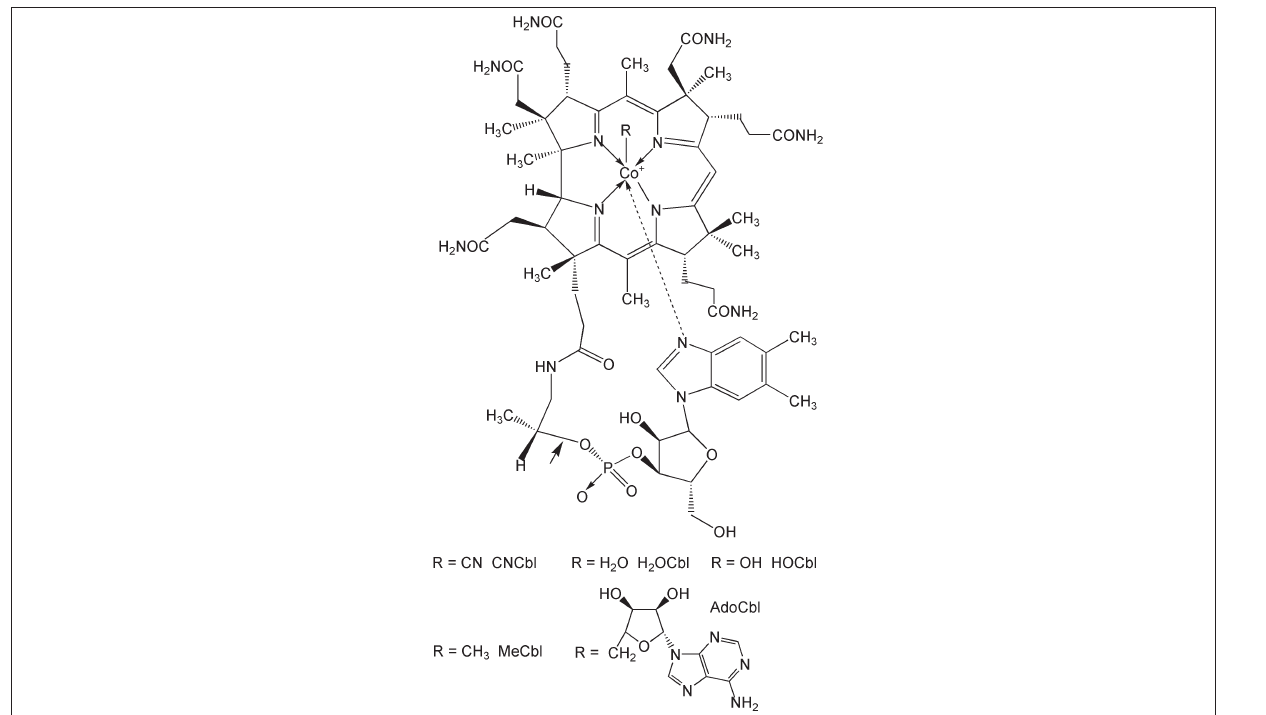
O, H OCbl), hydroxo cobalamin (R=OH, HOCbl), 2 2 (R=5’-deoxyadenosyl, AdoCbl). Cobalamins are shown 12 OCbl and HOCbl are found in an acid/base-dependent equilibrium 2